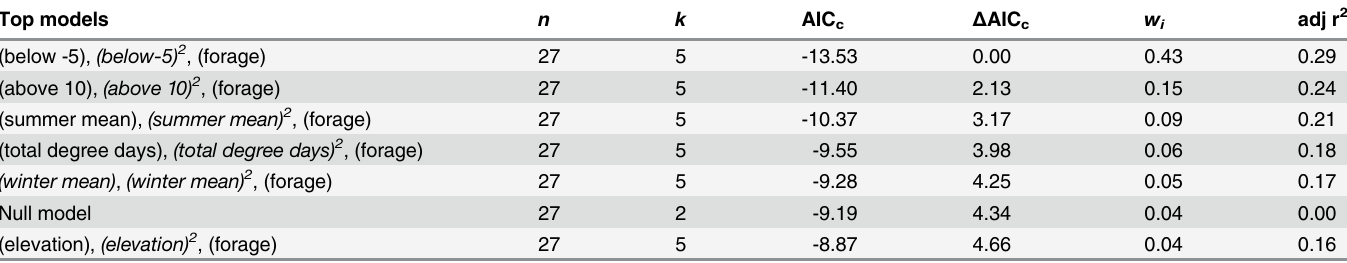
Table 3. Results of models fit to relative American pika scat density at a subset (n = 27) of Wind River Range (Wyoming, USA) sites (2010) using temperature sensor data showing the five best-supported models that replaced elevation with climate effects, as well as the best habitat variable model and the null